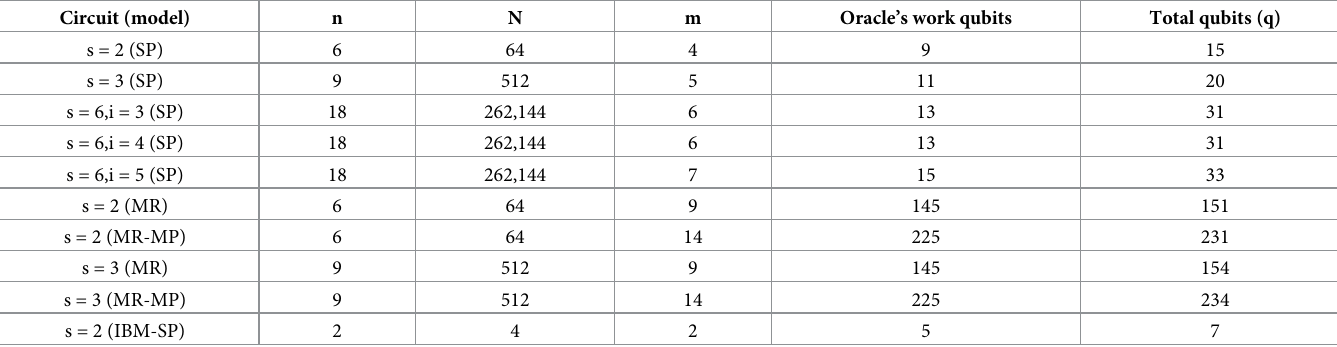
Table 1. A brief description of each circuit in this